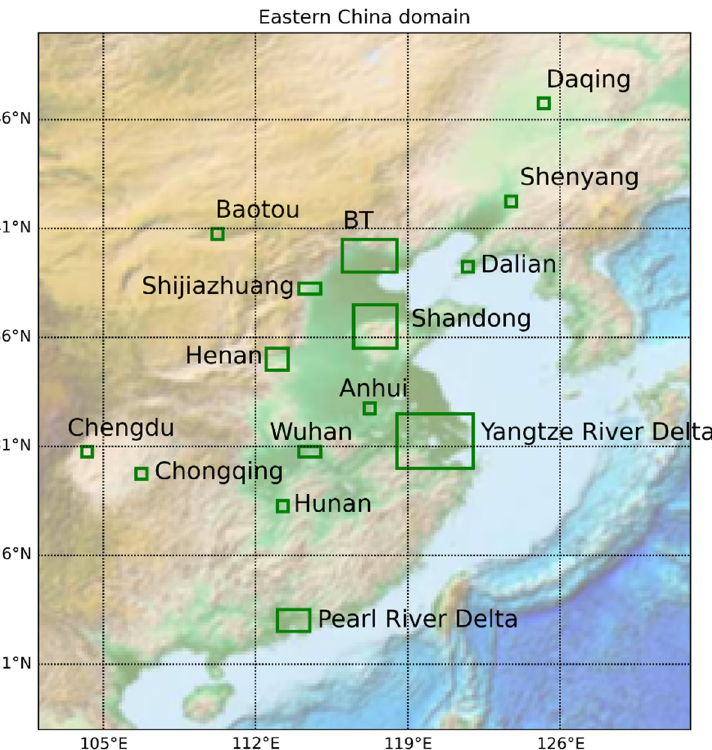
Figure 2. The study domain. Selected locations presenting the most urbanized and industrialized regions (see Section 3.3) are indicated by the rectangles.